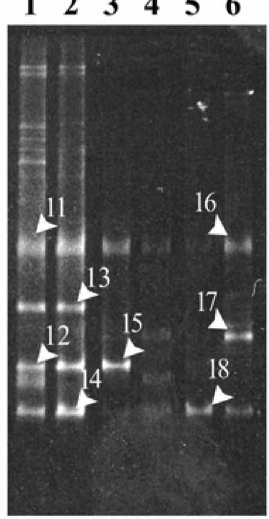
Figure 2. DGGE profiles of the vaginal lactobacilli population from the subject during the 6 weeks of the study (lanes 1 to 6=weeks 1 to 6). See Table I for Lactobacillus species associated with the arrowed bands shown